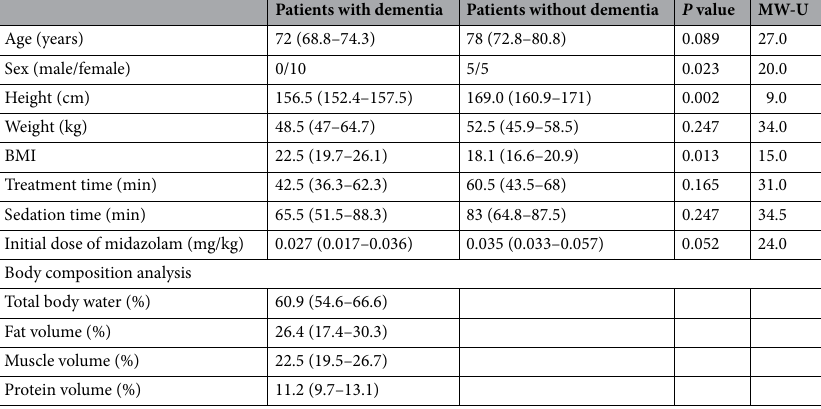
Table 1. Characteristics of the participants. BMI body mass index, MW-U Mann–Whitney U